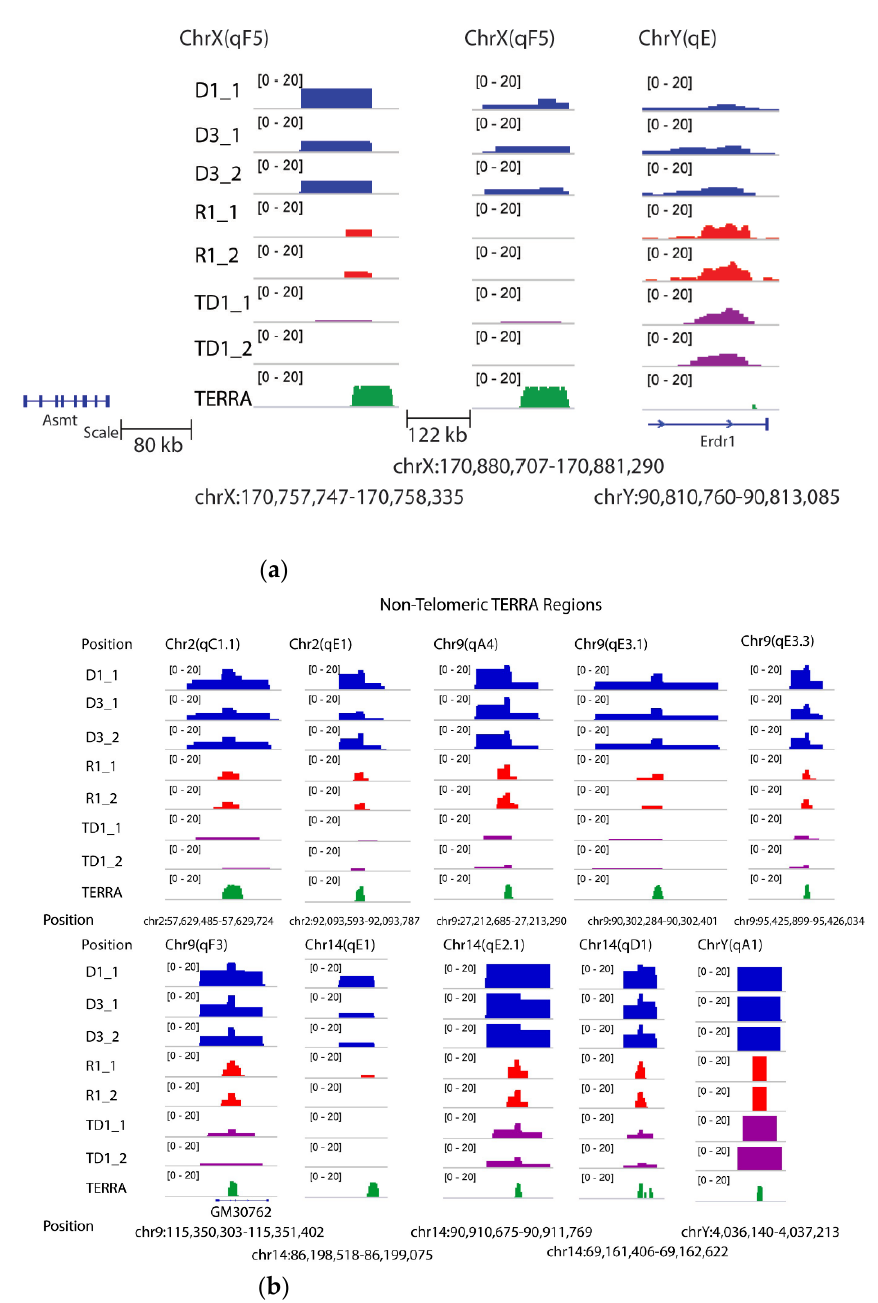
Figure 5. Non telomeric TERRA over mouse chromosomes. ( a ) TERRA spots are present in sex chromosomes. TERRA Regions on ChrX and ChrY. The number of TERRA foci co-localized with pseudoautosomal regions for instance, Asmt on X and Erdr1 on Y according to Lee et al [32]. ( b ) TERRA spots are present on chromosomes 2, 9, 14 and Y.